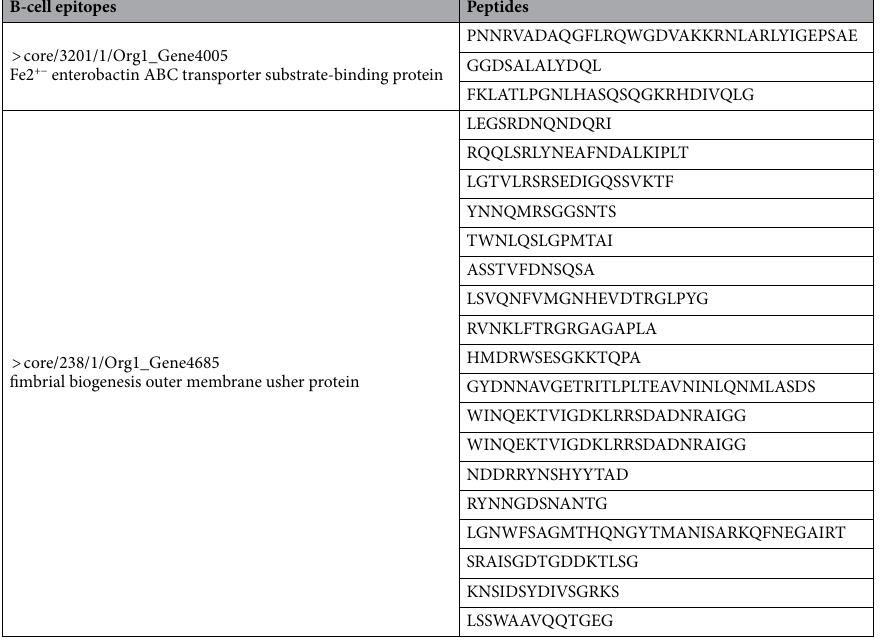
Table 3. Predicted B-cell epitopes and shortlisted vaccine targets.